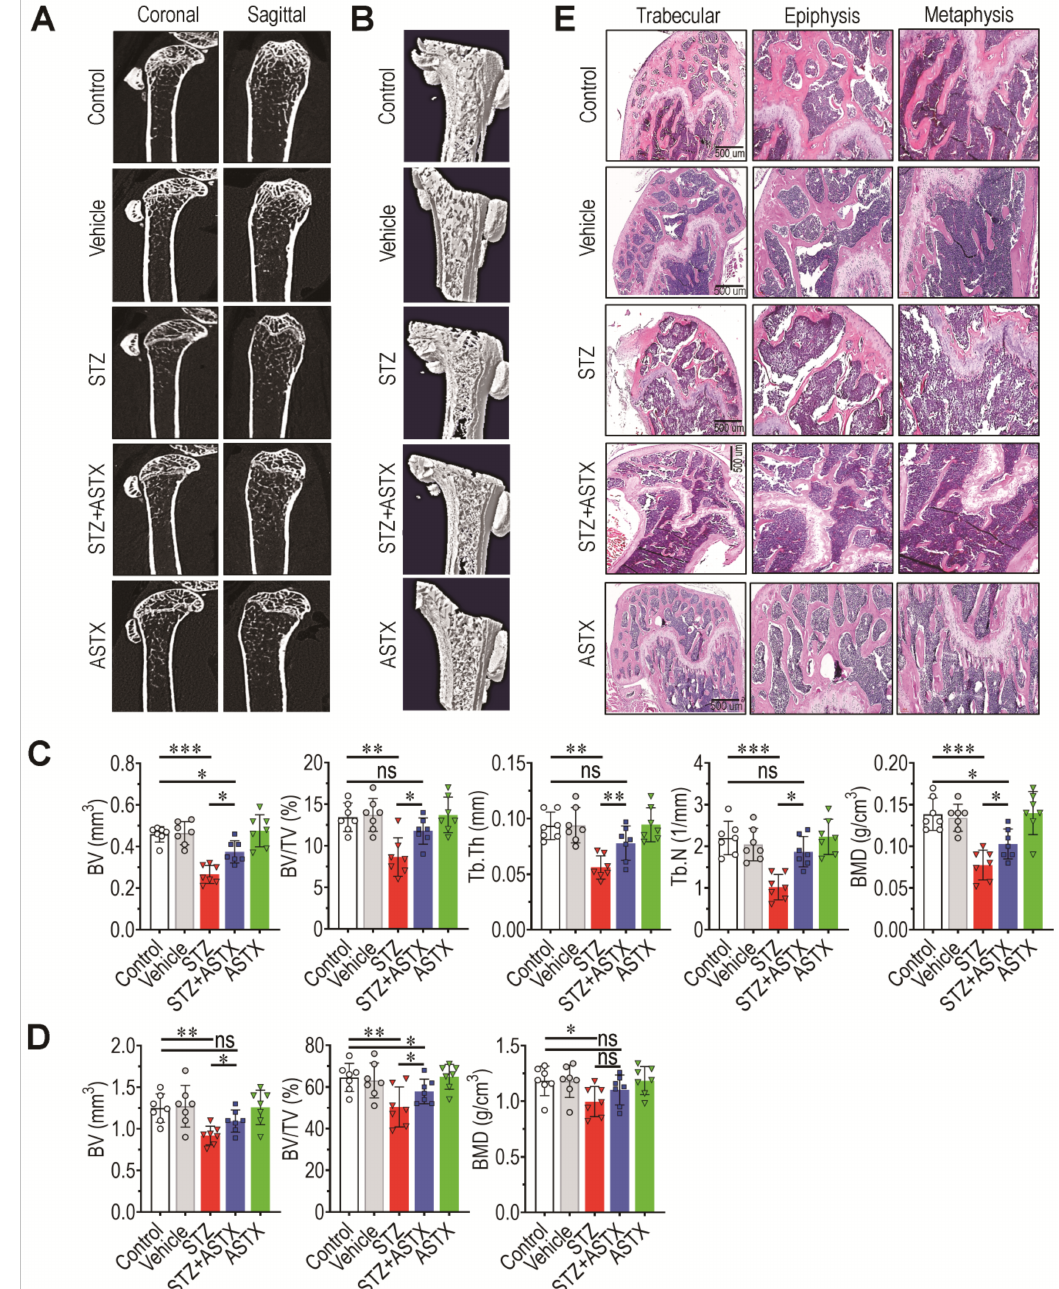
Figure 2. Long-term administration of ASTX ameliorates BM impairment in STZ-injected mice. ( A ) Representative 2D µ CT images of coronal and sagittal sections of femoral bones at 60 days post-hyperglycemia induction. ( B ) Reconstructed three-dimensional µ CT images of femoral bones. Based on the three-dimensional µ CT reconstruction, bone parameter values in ( C ) trabecular and ( D ) cortical regions were calculated ( n = 7/group). ( E ) H&E staining showing bone mass accrual in the trabecular bone of mice 60 days after hyperglycemia induction. Bar = 500 µ m. * p < 0.05, ** p < 0.01, and *** p < 0.001 by unpaired Student’s t -test. ns, not